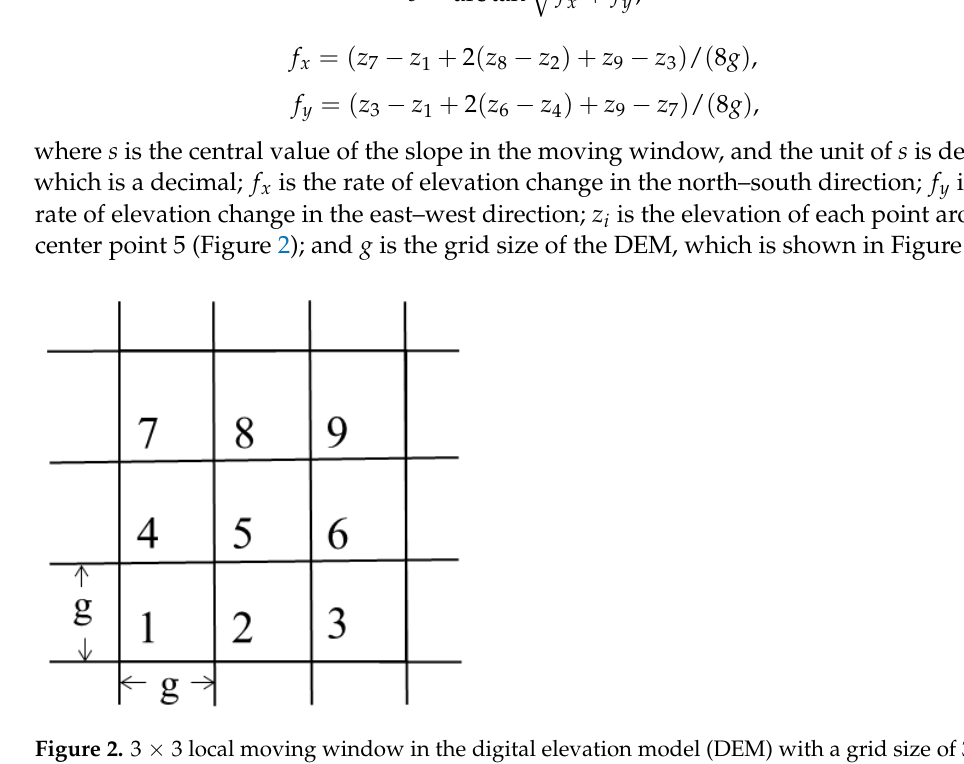
Figure 2. 3 × 3 local moving window in the digital elevation model (DEM) with a grid size of 30